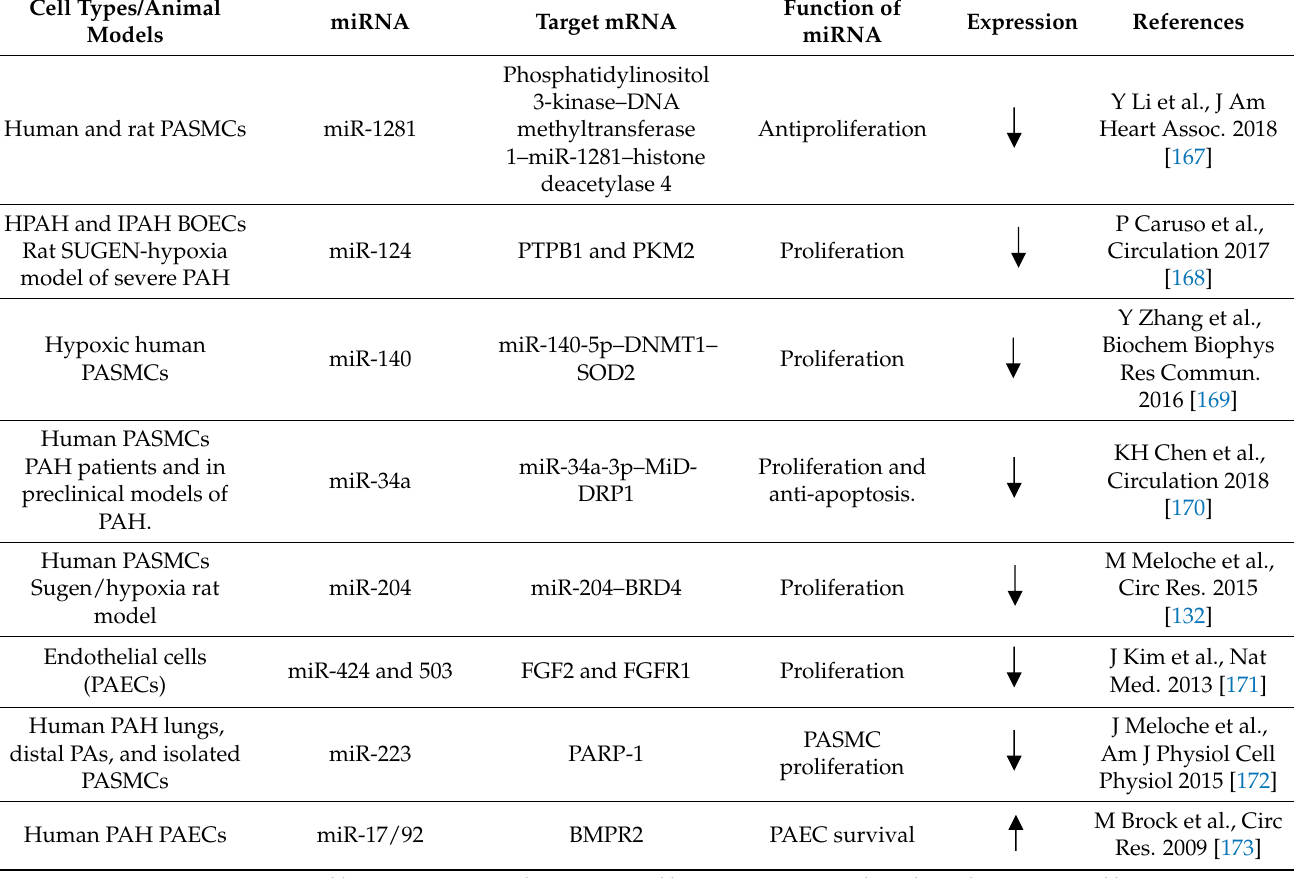
Table 2. List of important dysregulated miRNAs in PAH.